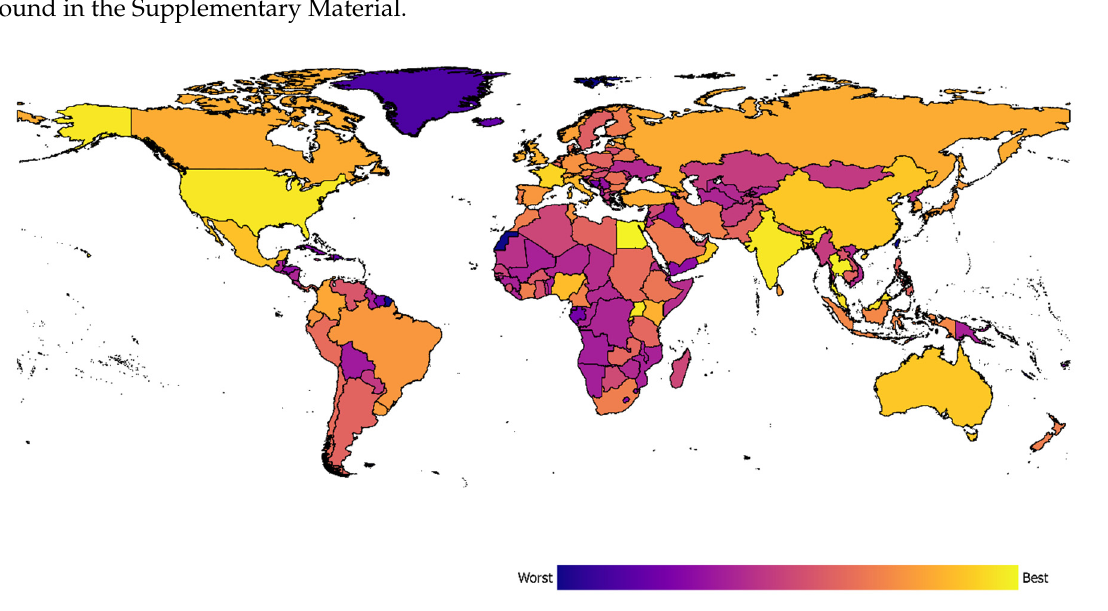
Figure 17. Global view on the cybersecurity dimension.